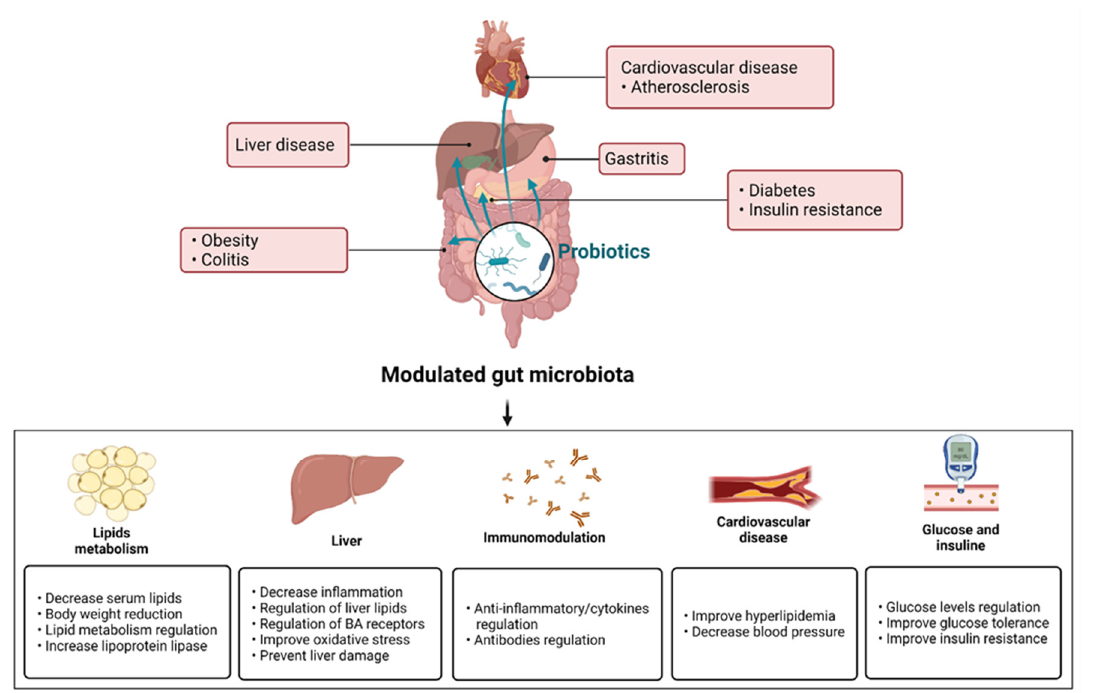
Figure 1. A balanced gut microbiota implies an increase in the abundance and diversity of beneficial species and a decrease in pathogenic bacteria. This leads to reduction in intestinal hyperpermeability and the prevention of infections. Prebiotics, probiotics, and synbiotics are related to hepatic, cardiovascular, gastrointestinal, and metabolic disorders; for example, liver injury, such as NAFLD and NASH; gastrointestinal diseases, such as gastritis and colitis; diseases related to lipid metabolism, including hyperlipidemia, obesity, and atherosclerosis; and diabetes. The administration of prebiotics, probiotics, and synbiotics confers various benefits. In lipid metabolism, serum lipid regulation has been reported, specifically of TC, VLDL-C, LDL-C, TG, and TBA; this regulation has been related to the low expression of SREBP-1c and CYP7A1, among other effects, in addition to the decrease in body weight and the positive regulation of PPAR- α , PPAR- γ , and lipoprotein lipase. Liver injury has been improved to reduce AST, ALT, AP, oxidative stress, and hepatic lipid accumulation. An immunomodulatory effect was observed, mainly anti-inflammatory, due to the decrease in proinflammatory cytokines (TNF-alpha, IL-6, IL-1 β , and C-reactive protein) and the increased expression of anti-inflammatory cytokine IL-10 and the antibody IgA. Cardiovascular diseases have been improved for blood pressure regulation (systolic and diastolic) and serum levels decreased in hyperlipidemia. Finally, in diabetes, significant reductions in glucose serum levels, fasting serum glucose, glucose tolerance, and insulin resistance have been observed.